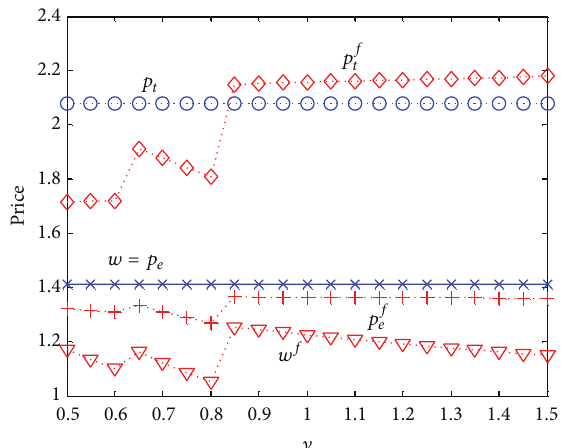
Figure 5: Effect of service level and free-riding on channel